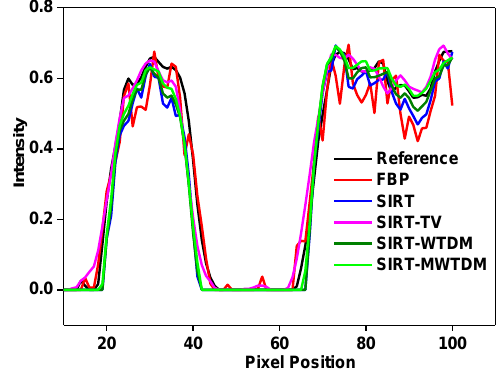
Figure 12. The profile of the reconstructed images.